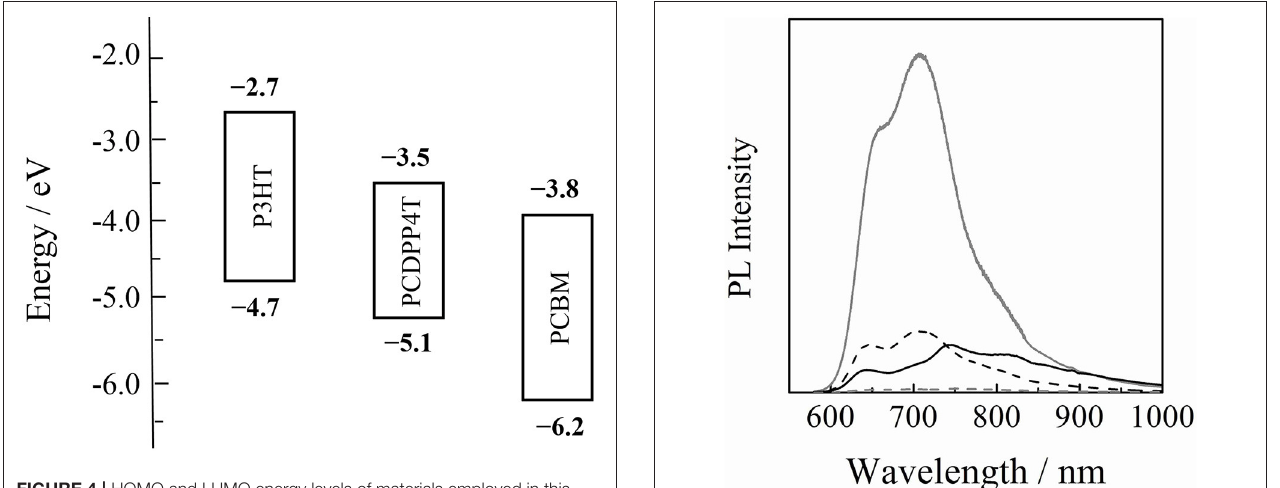
binary blend to 100% for the P3HT/PCBM/PCDPP4T